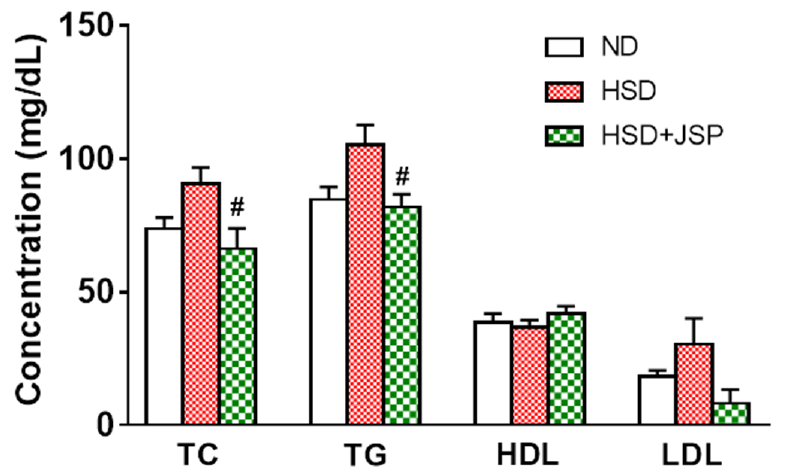
Figure 5. JSP supplementation significantly decreased total cholesterol and triglycerides in HSD-fed mice. ND: Normal Diet; HSD: High-Sugar Diet; and JSP: Jackfruit Seed Powder. # p < 0.05 vs. HSD by one-way ANOVA followed by Tukey’s post hoc test. Bars represent mean ± SEM. n ≥ 3 for each group.